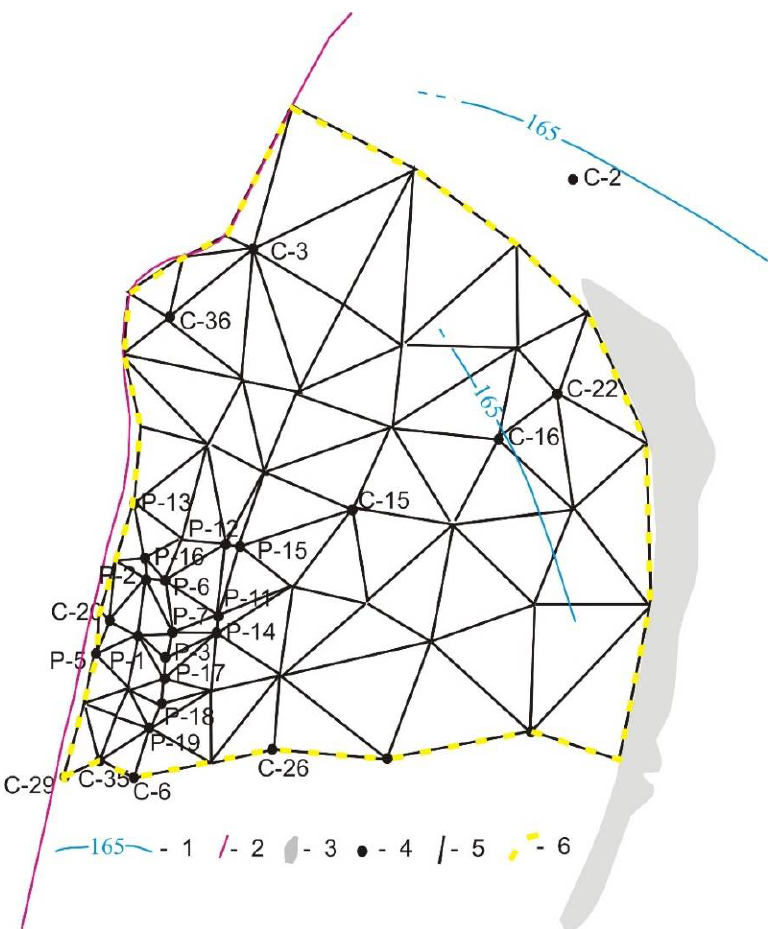
Figure 6. Modeling domain with finite elements. (1) Level of hydraulic head; (2) right-bank fault, (3) zone of wedging out of Horizon I; (4) boreholes; (5) boundaries of finite elements; (6) boundary of the modeling domain.